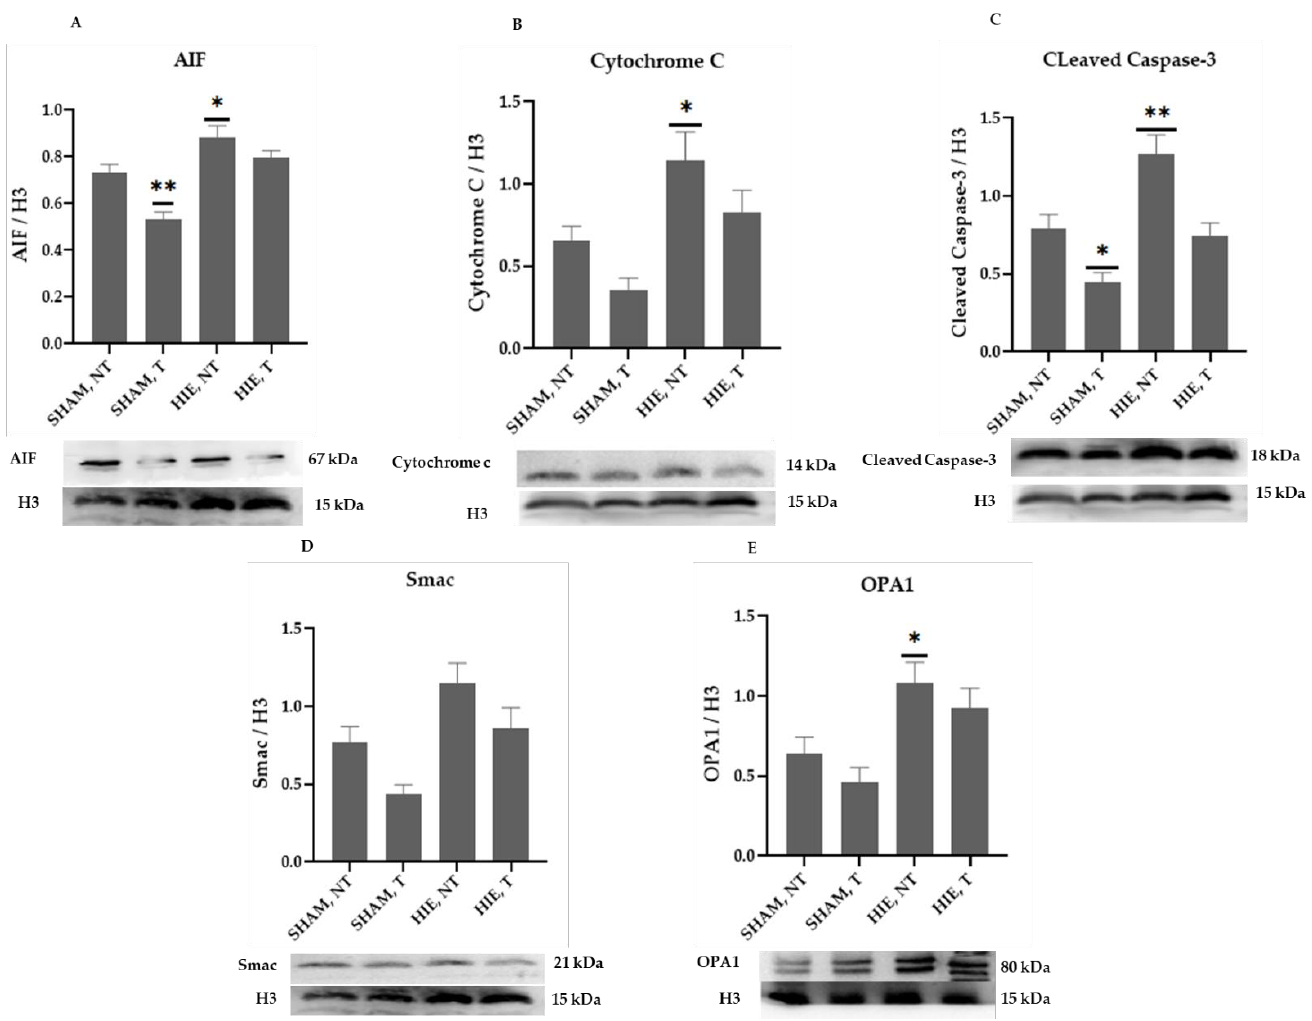
Figure 5. Protein changes in the nuclei of the cerebral cortex . Examples of Western blot bands normalized to H3 are presented (with the matching wells). Units are presented relative to H3 content. ( A ) AIF, apoptosis-inducing factor, ( B ) cytochrome c, ( C ) cleaved caspase-3, ( D ) Smac/Diablo, and ( E ) OPA1. Asterisks denote statistically significant differences between groups (*, vs. SHAM, NT).